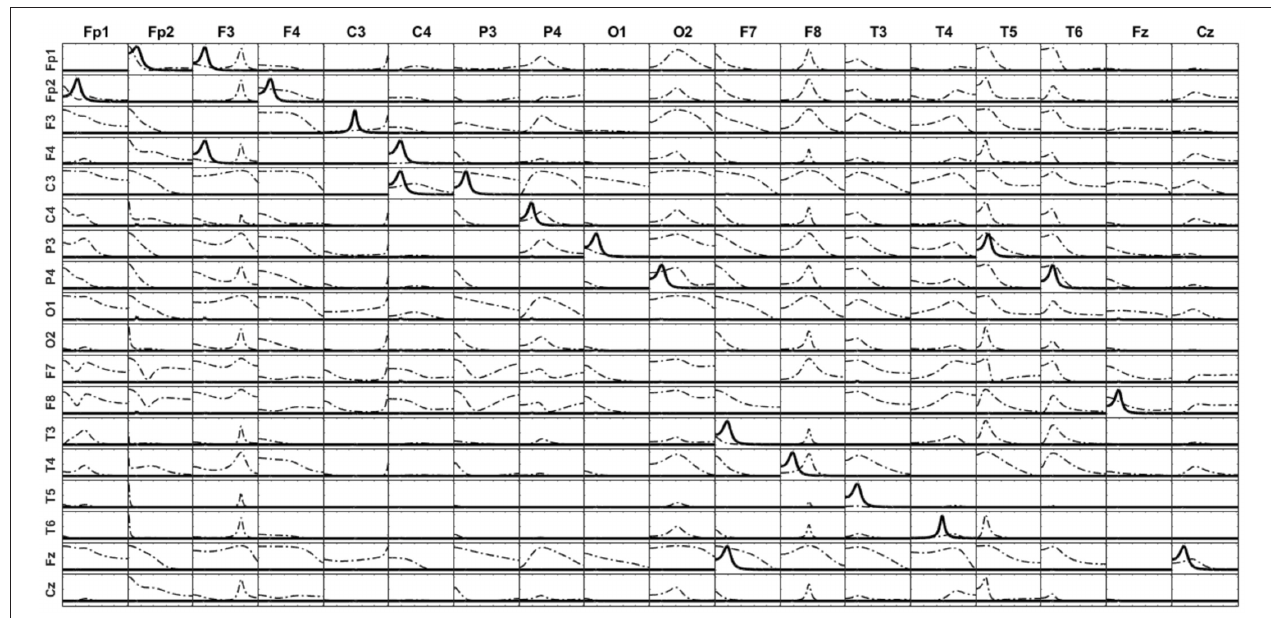
FIGURE 7 | iCoh measures of the 17 sources of the reconstructed system. Solid thick lines after unmixing the sLoreta reconstruction; dashed lines before